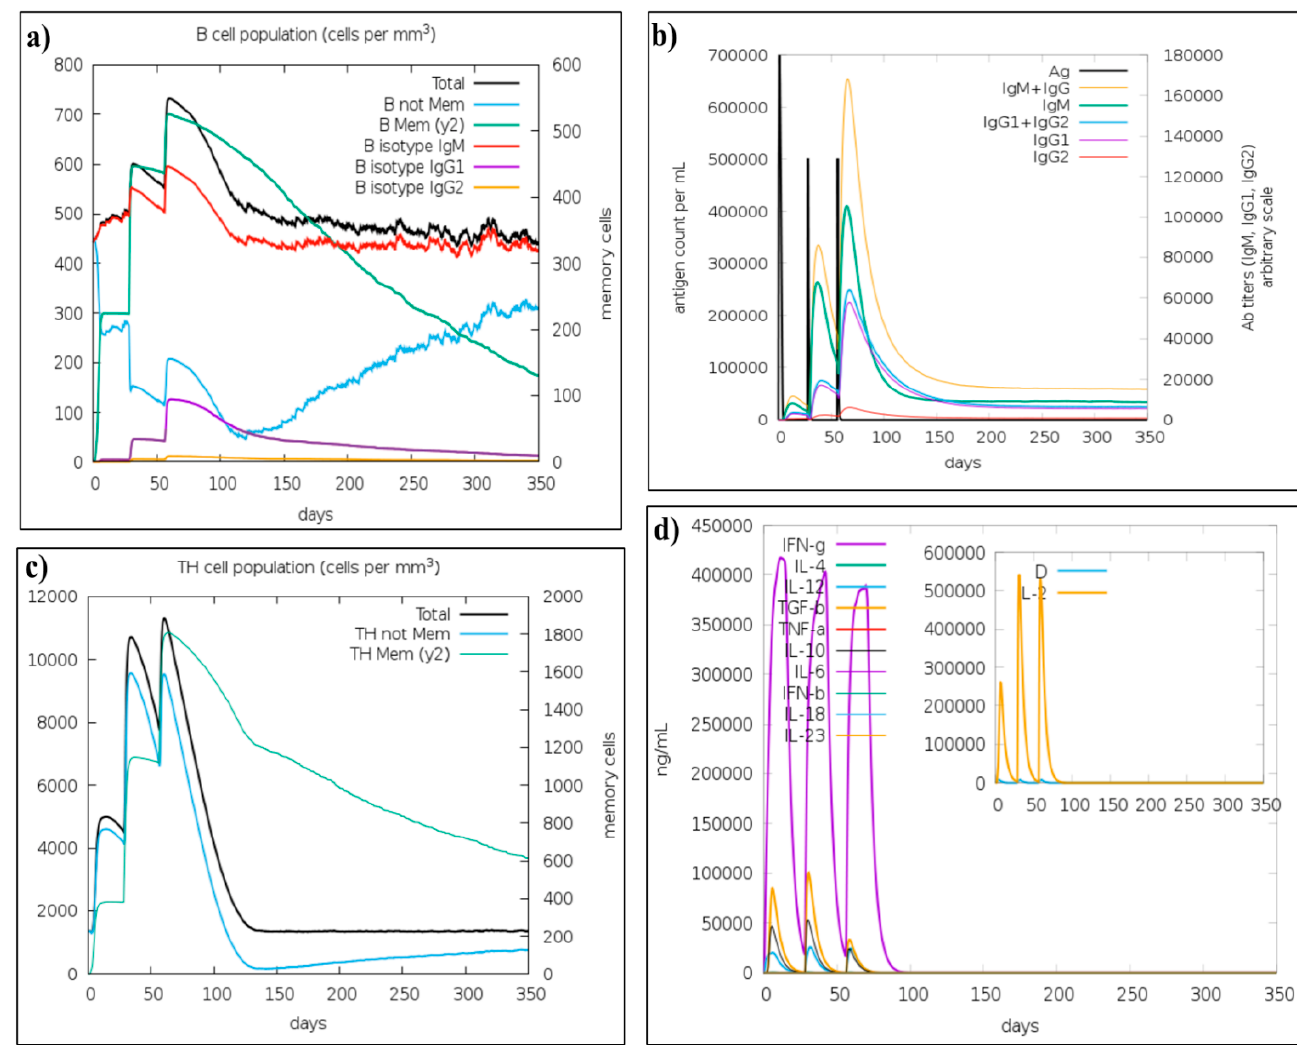
Figure 5. C-ImmSim presentation of an in silico immune simulation with the vaccine construct. ( a ) The generation of B-cells after the three injections. ( b ) Immunoglobulin production in response to antigen injections (various subtypes of immunoglobulin are represented as colored peaks). ( c ) The generation of Helper-T cells. ( d ) The cytokine profile.